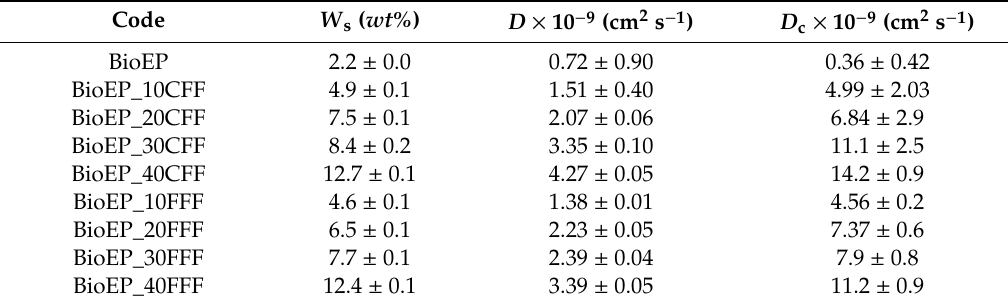
Table 4. Values of water saturation ( W s ), diffusion coefficient ( D ) and the corrected diffusion coefficient ( D c ) for BioEP resin and BioEP composites reinforced with different CFF and FFF content.